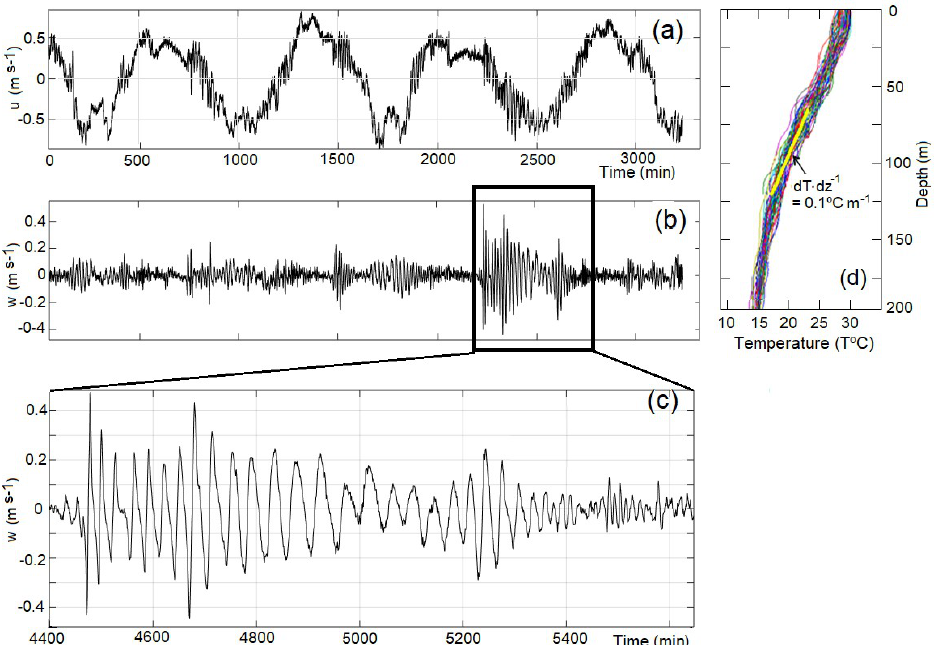
Figure 8. Measured currents at 62 m depth at mooring northeast of San Esteban Sill. ( a ) speed of the horizontal component v and ( b ) vertical component w of the current velocity. ( c ) a group of large-amplitude solitons (wave heights of 55–70 m, periods of 12–15 min). ( d ) Vertical temperature profiles measured near the mooring during the experiment (19 casts total).